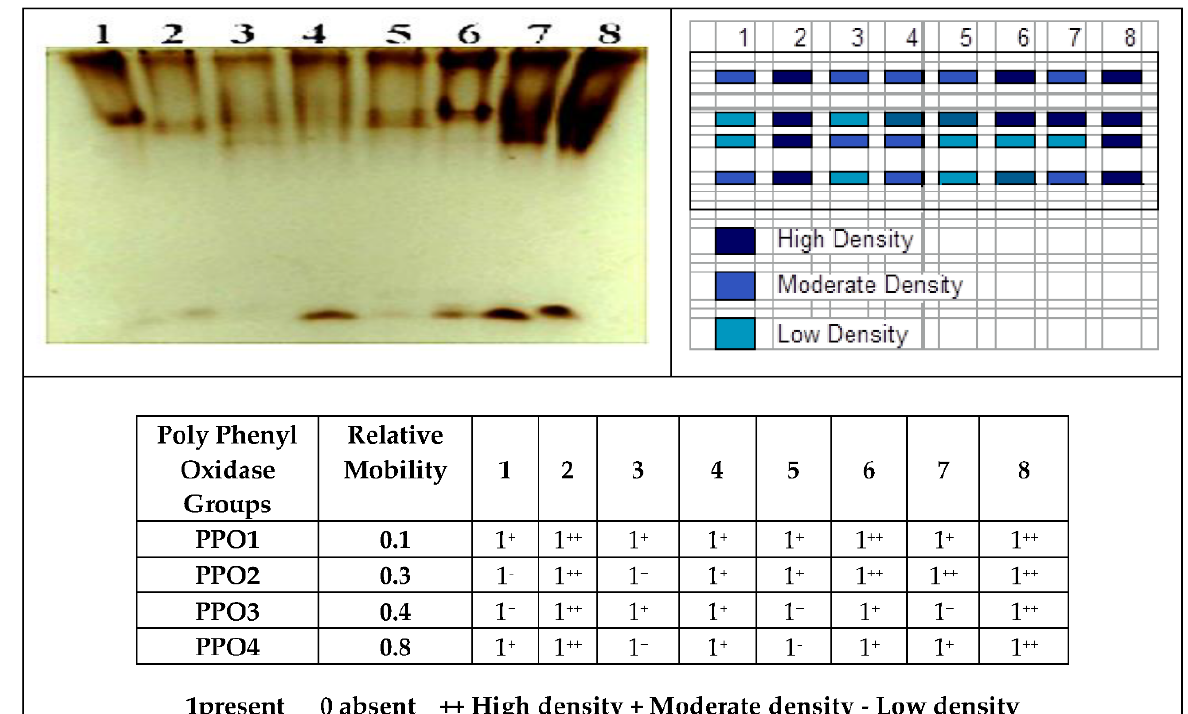
Figure 7. Effect of Se-NPs on peroxidase isozymes of Vicia faba under pot conditions 1: Control (H.). 2: Control (Inf.). 3: Soaking Nano (H.) . 4: Soaking Nano (Inf.). 5: Soaking + Spray Nano (H.). 6: Soaking + Spray Nano (Inf.). 7: Spray Nano (H.). 8: Spray Nano (Inf.).